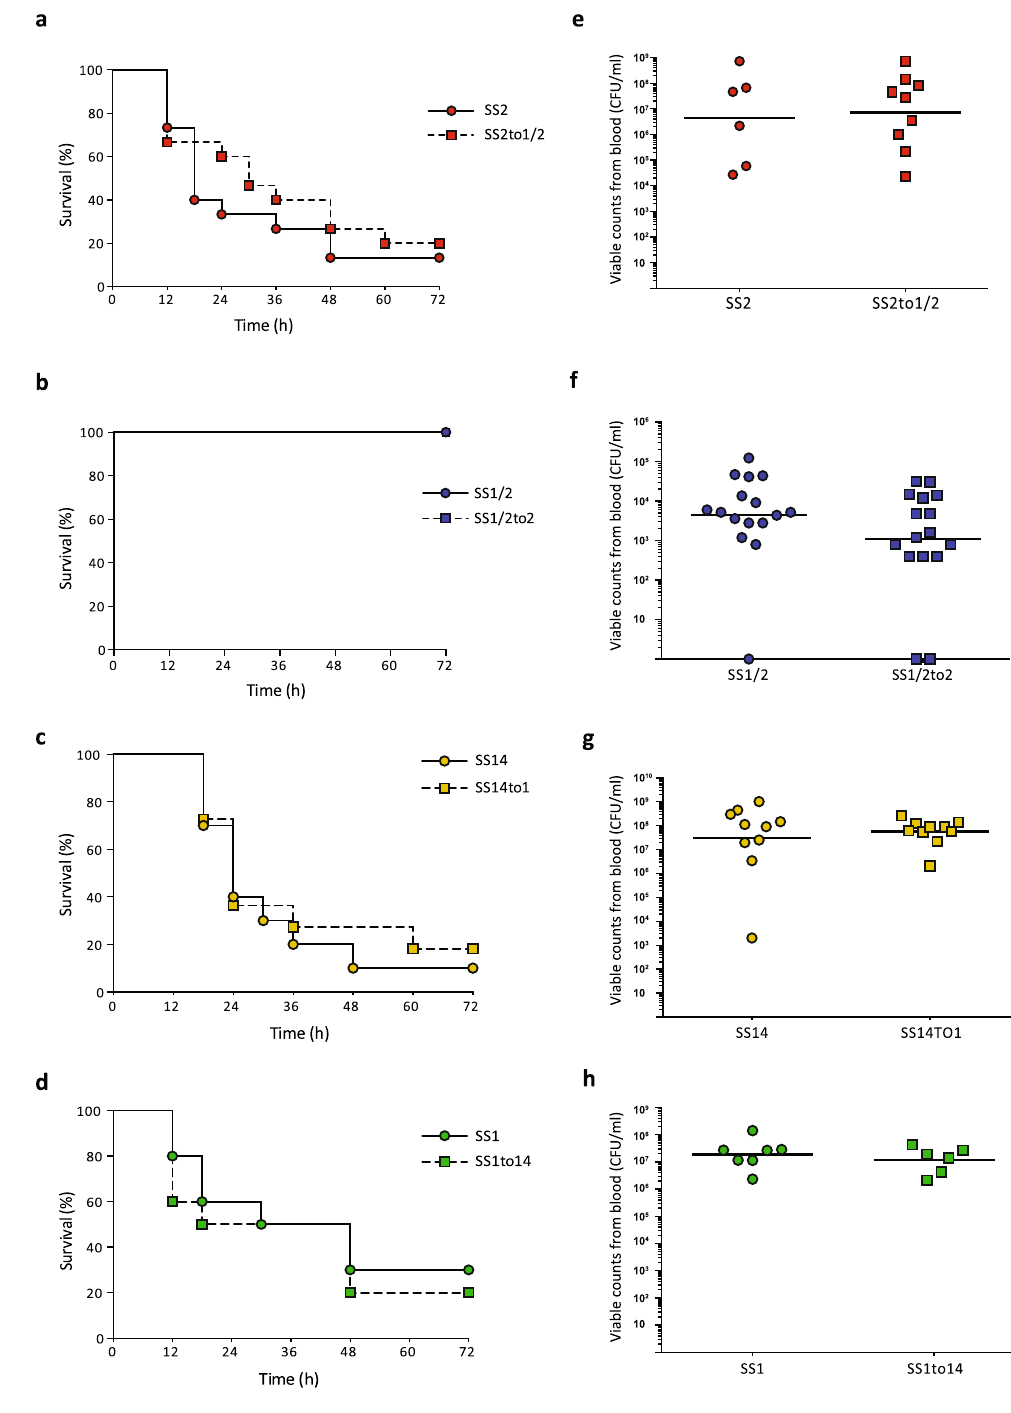
Figure 6. Serotype switching does not impact strain virulence. ( a–d ) Survival of CD1 mice inoculated by intraperitoneal injection with either 5 × 10 7 CFU of serotype 2 ( a ) or 1/2 ( b ) strains or with either 1 × 10 8 CFU of serotype 14 ( c ) or 1 ( d ) strains. In all cases, Log-Rank (Mantel-Cox) test revealed no significant differences in survival rates between the field parental strains and derivative mutants. All control animals injected with vehicle (Todd Hewitt Broth) survived the trial (data not shown for simplicity). ( e–h ) Bacterial load in blood was evaluated in all groups by drawing 5 μ l of blood from the tail vein of mice followed by plating and enumeration (see methods). ( e ) Serotype 2 field strain and derived mutant SS2to1/2. ( f ) Serotype 1/2 field strain and derived mutant SS1/2to2. ( g ) Serotype 14 field strain and derived mutant SS14to1. ( h ) Serotype 1 field strain and derived mutant SS1to14. No significant differences in bacterial load were observed between parental strains and their corresponding mutants (Mann-Whitney Rank Sum test, P <